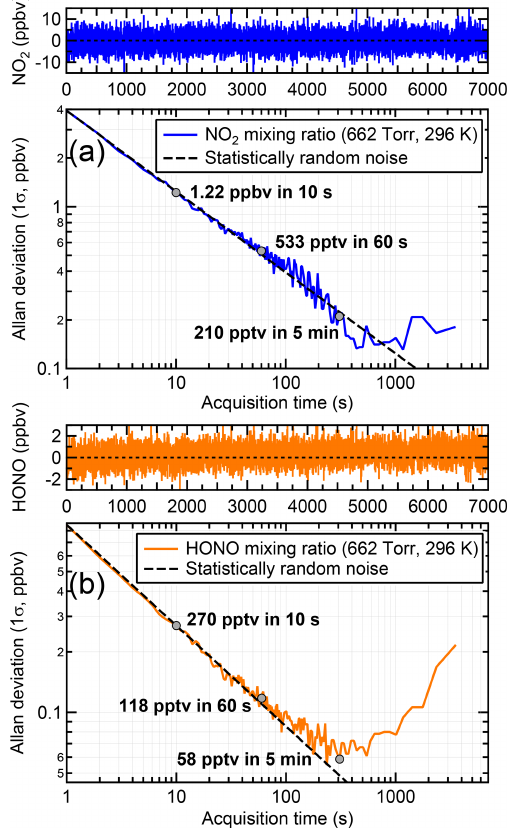
Figure 6. Allan deviation plots for (a) NO 2 and (b) HONO. The optimum signal averaging time is the inflection point in each vari- ance trace. Each trace was generated by sampling zero air through HODOR for 2h at a flow rate of 2slpm and at ambient pressure ( ∼ 880hPa) and temperature (296K), followed by calculation of the absorption coefficient and fitting of the respective convolved ab- sorption cross